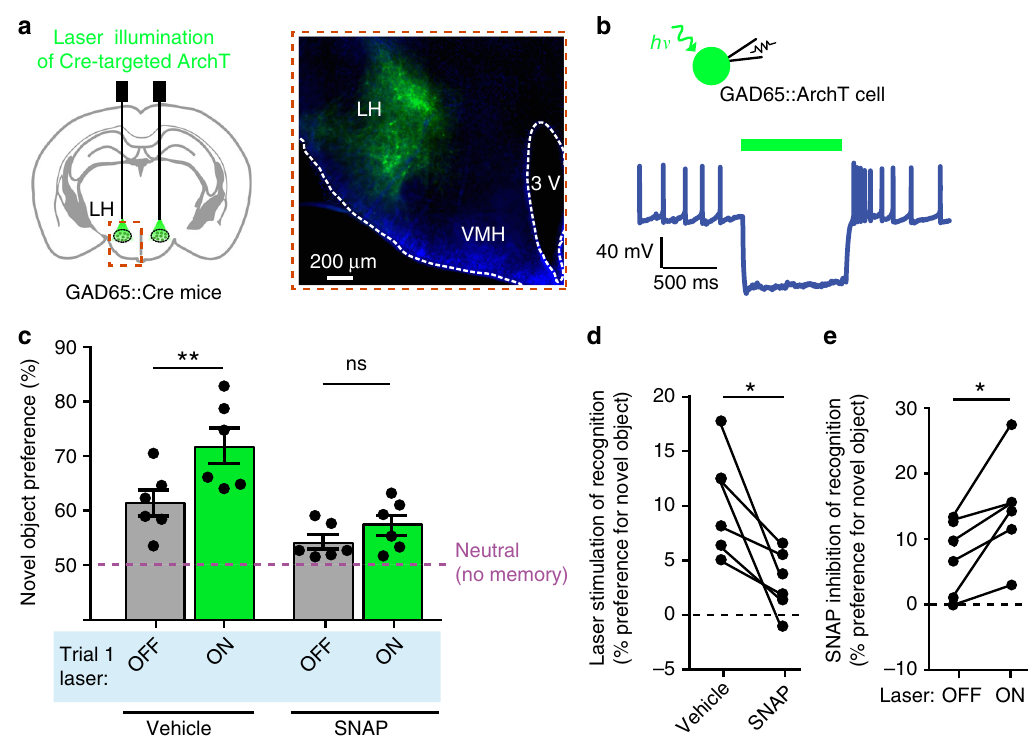
Fig. 4 GAD65 LH cells control object memory via MCH signaling. a Targeting schematic (left) and expression (right) of ArchT in GAD65 LH cells. b Patch- clamp recording from GAD65 LH ::ArchT cells con fi rming cell inhibition by green light ( n = 5 cells). c Role of GAD65 LH cell activity in object memory formation (experimental design as in Fig. 2c). Data are shown as individual points (mice) and their means ± s.e.m. Object-area-entry-associated GAD65 LH cell optosilencing during trial 1 increased object recognition in trial 2 in the absence (2-way ANOVA, F (1, 5) = 17.1, p = 0.0090, Tukey ’ s multiple comparisons test: ** p = 0.0036) but not presence of MCHR blocker SNAP94847 (SNAP) (2-way ANOVA, F (1, 5) = 17.1, p = 0.0090, Tukey ’ s